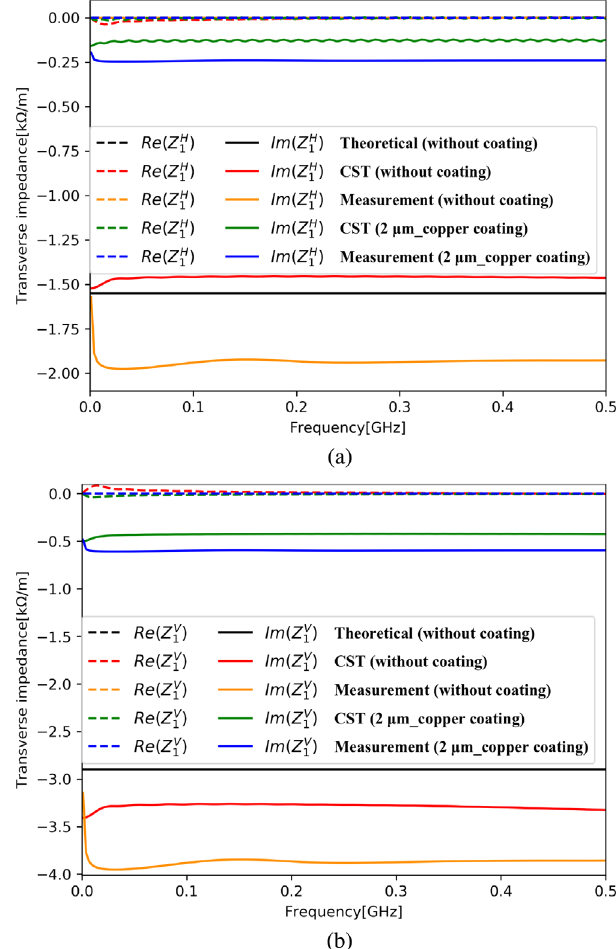
FIG. 16. CST simulation and measurement results for the transverse broadband impedance of ceramic rings. (a) Horizontal (b)